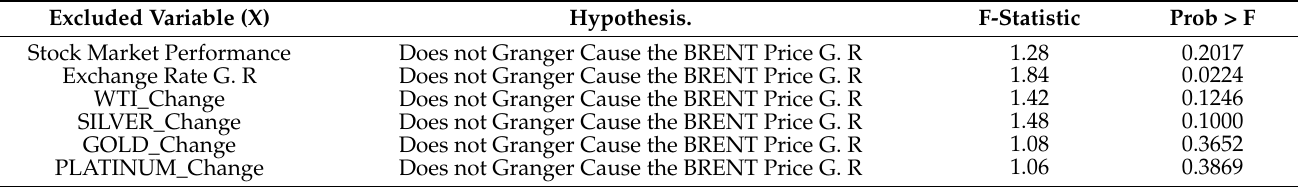
Table A16. Granger Causality test related to the BRENT Price G. R (Regression with Driscoll–Kraay Approach). Excluded Variable (X)